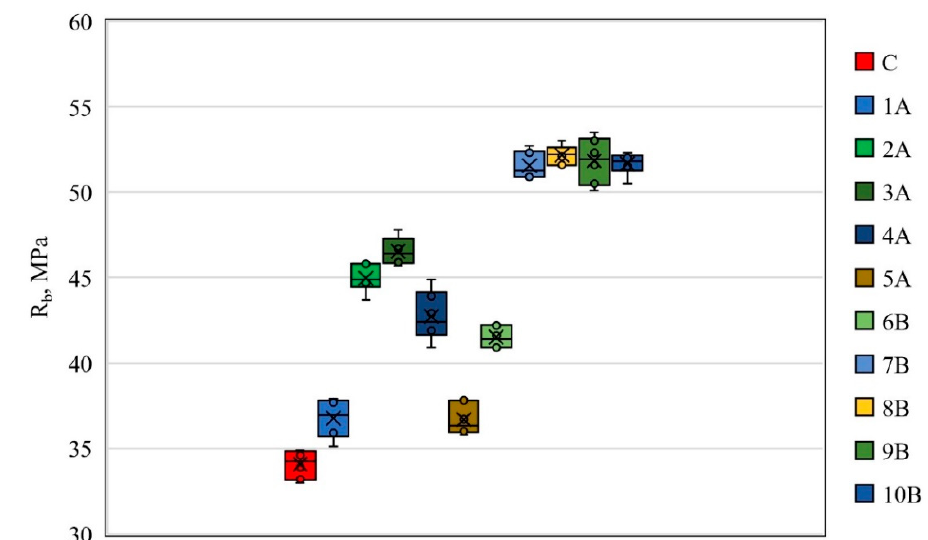
Figure 7. Compressive strength of fine-grained geopolymer concrete.